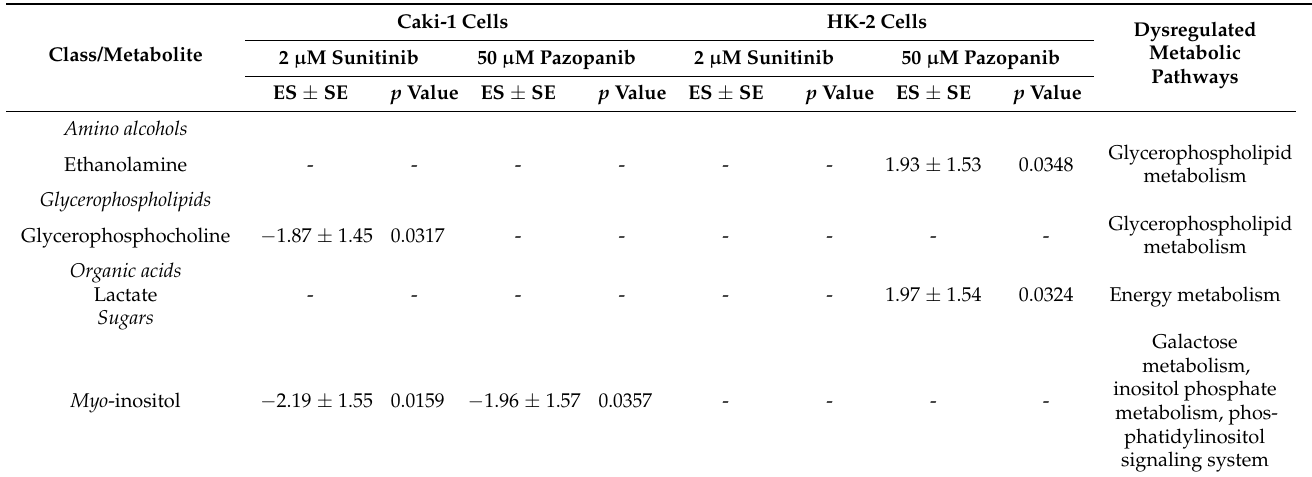
Figure 4. Impact of TKIs on the exometabolome (extracellular metabolites present in culture me- dium) profile of Caki-1 cells. ( a , b ) PLS-DA scores scatter plots (left) and loading plots (right) ob- tained for ( a ) non-exposed cells (green circles, n = 5) vs. cells exposed to 2 µM sunitinib (red circles, n = 4) and ( b ) non-exposed cells (green circles, n = 5) vs. cells exposed to 50 µM pazopanib (blue circles, n = 3). ( c ) Heatmap illustrating the mean levels of metabolites changing in culture media of Caki-1 cells after exposure with 2 µM sunitinib and 50 µM pazopanib. Rows correspond to the mean normalized peak area of each metabolite colored from minimum value (dark blue) to maximum value (dark red), while the columns represent each sample group. The control group represented in the first column corresponds to non-exposed cells. The statistical significance was assessed by com- parison with the control cells (* p < 0.05). Abbreviations: Arg—arginine, Glu—glutamate, Leu—leu- cine, Phe—phenylalanine, Tyr—tyrosine, Val—valine. The PLS-DA scores scatter plots obtained for Caki-1 exometabolome (Figure 4) showed a reasonable separation between the extracellular culture media of exposed and non-exposed cells (Q 2 ≥ 0.35). After inspection of the corresponding loading plots, the magnitude of variation and statistical significance of discriminant metabolites was as- sessed and is presented in Table 2 and the heatmap of Figure 4c. No separation was ob- served in the PCA and PLS-DA models of Caki-1 and HK-2 cells exposed to DMSO (vehi- cle) compared with controls (non-exposed cells). The exposure of Caki-1 cells to sunitinib unveiled a significant alteration of only one extracellular metabolite, whereas seven com- pounds were found significantly altered after pazopanib exposure. The relative compari- son with blanks (culture medium without cells) allowed the interpretation of metabolite